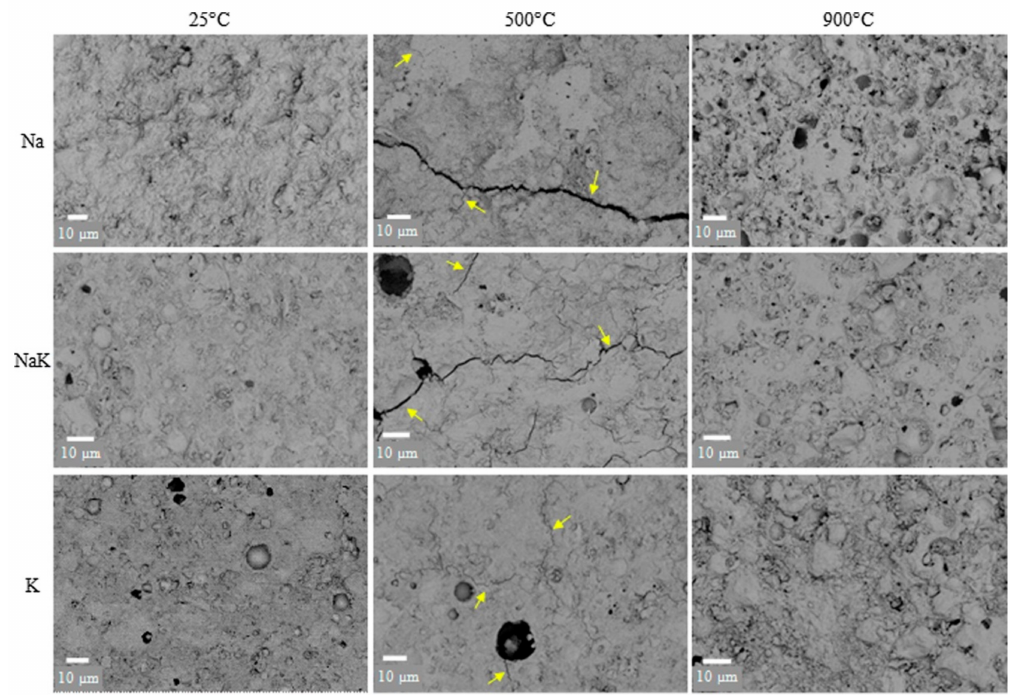
Figure 10. Formulation of micro-cracks in geopolymers upon the exposure to high temperature [169]. Reprinted with permission from Elsevier